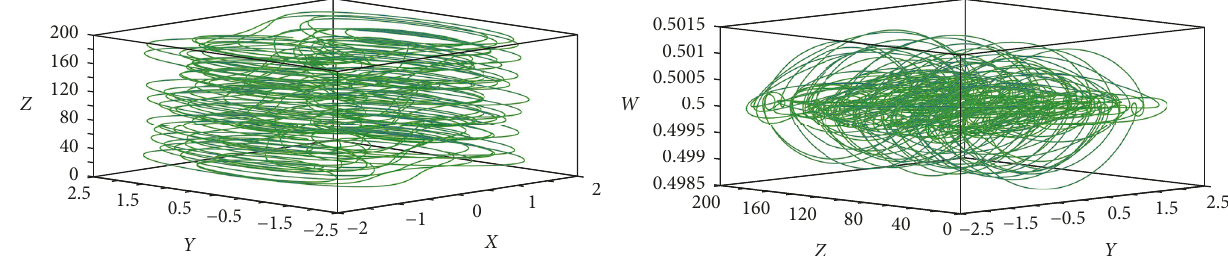
Figure 13: 3D phase portraits of the FOPF system implemented in FPGA with order 𝑞 = 0.998